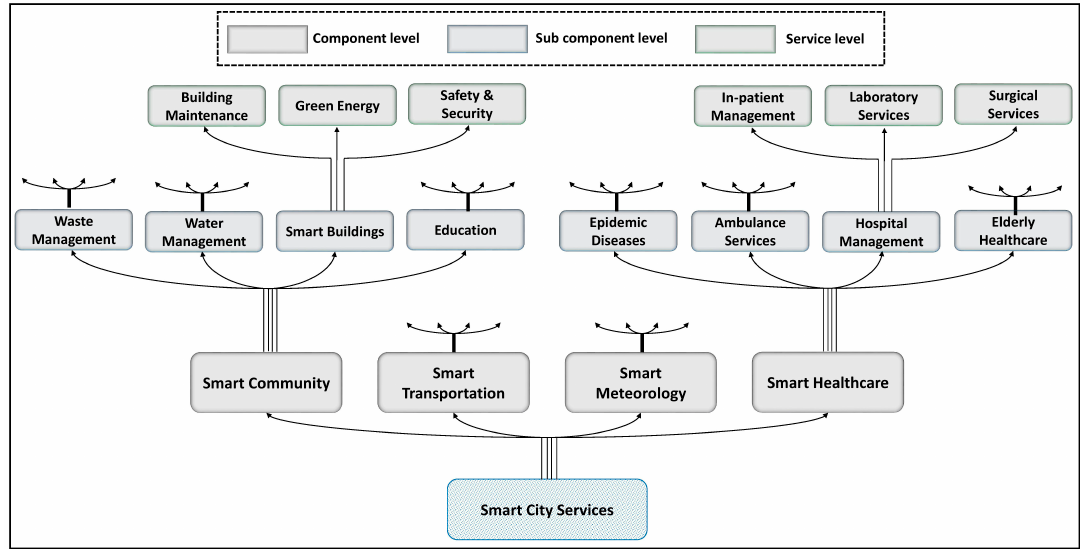
Figure 3. Expanded composition of service management layer.